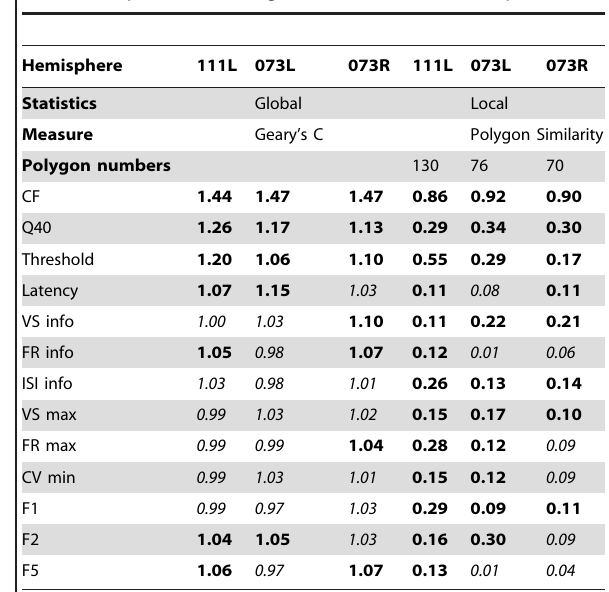
Table 2. Spatial clustering statistics of cortical